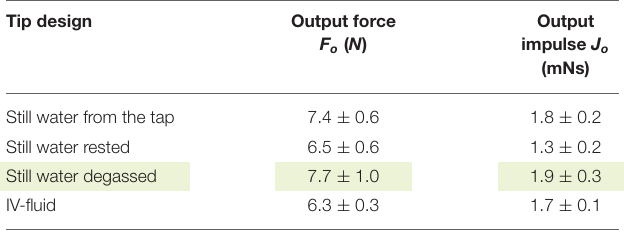
TABLE 5 | Overview of the results (mean ± standard deviation, n = 3) of the fluidic medium